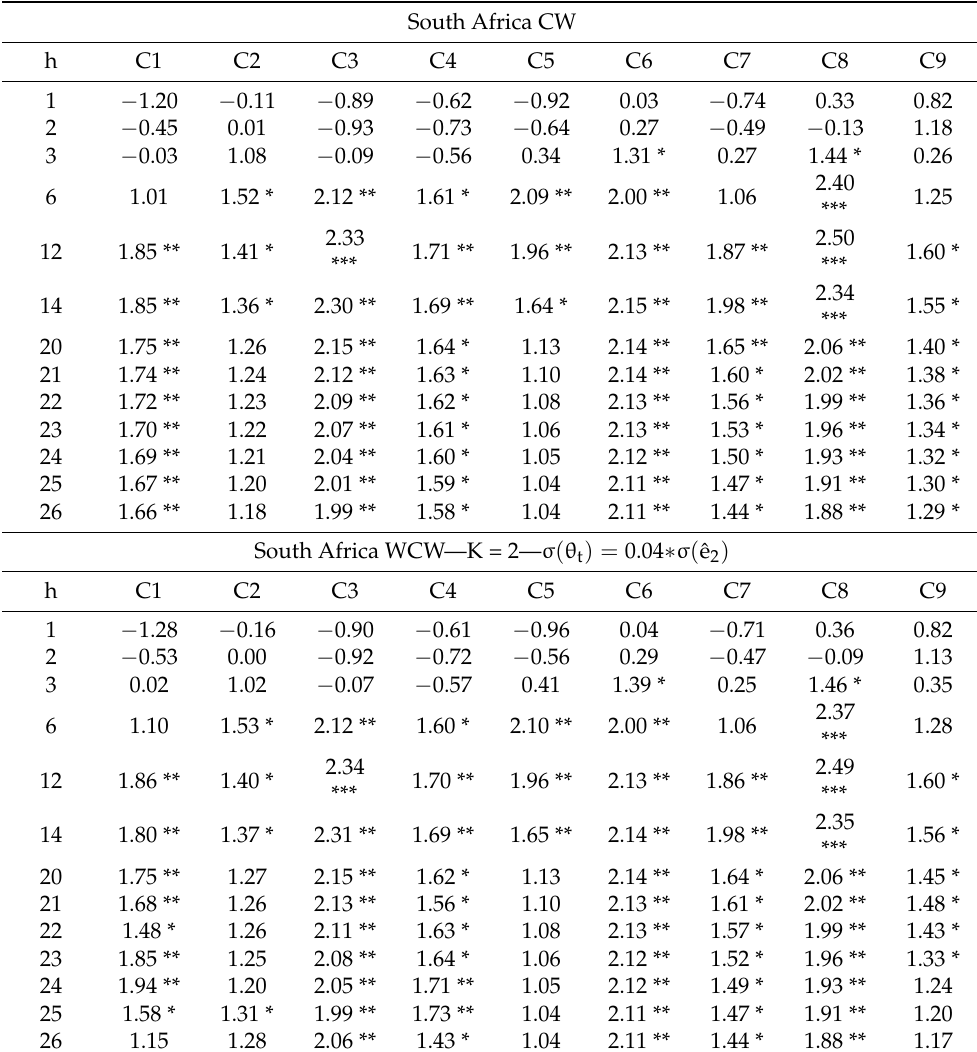
Table A3. Forecasting commodity prices with the South African exchange rate. A comparison between CW and WCW in iterated multi-step-ahead